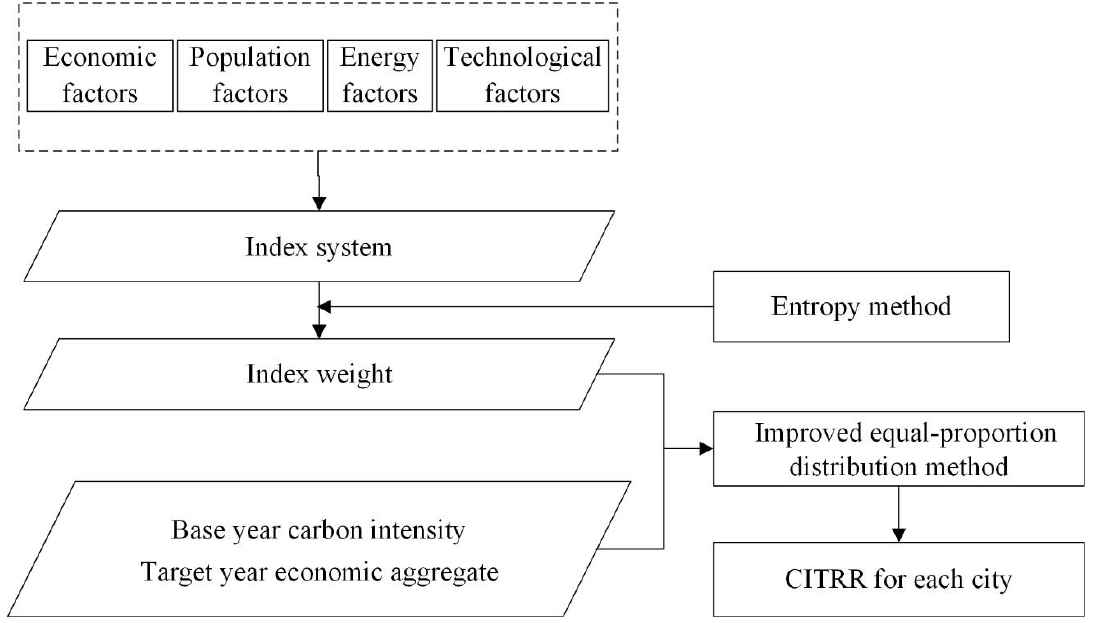
Figure 1. Technical route of the research.